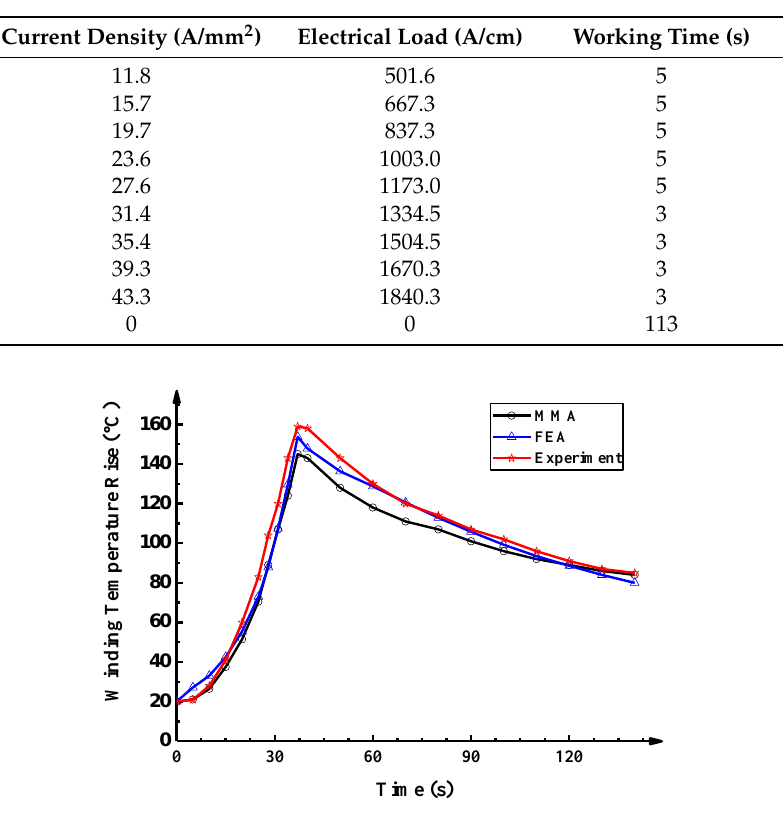
Figure 18. The temperature comparisons of the experiment measurement and simulations.